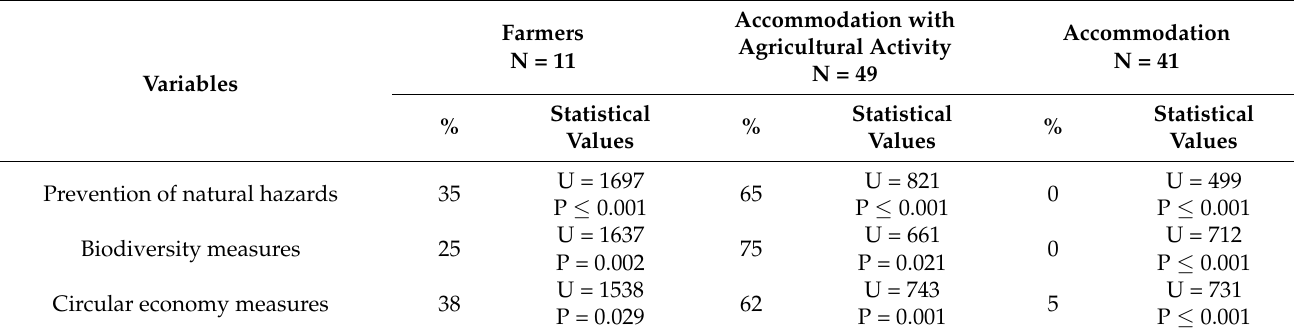
Table 9. A comparison of environmental variables between accommodation and other entrepreneurial